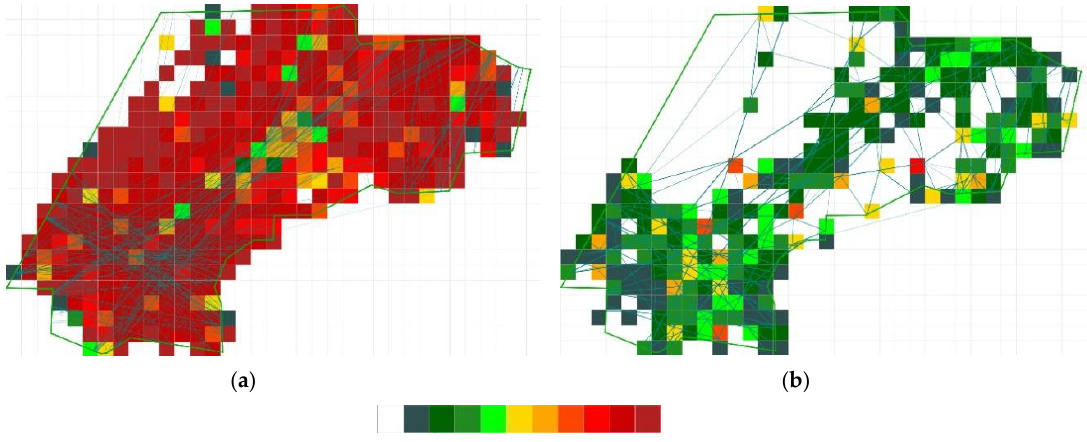
Figure 15. Structural complexity for intersections ( a ) and reduced main-flow network ( b ) for Scenario 2.